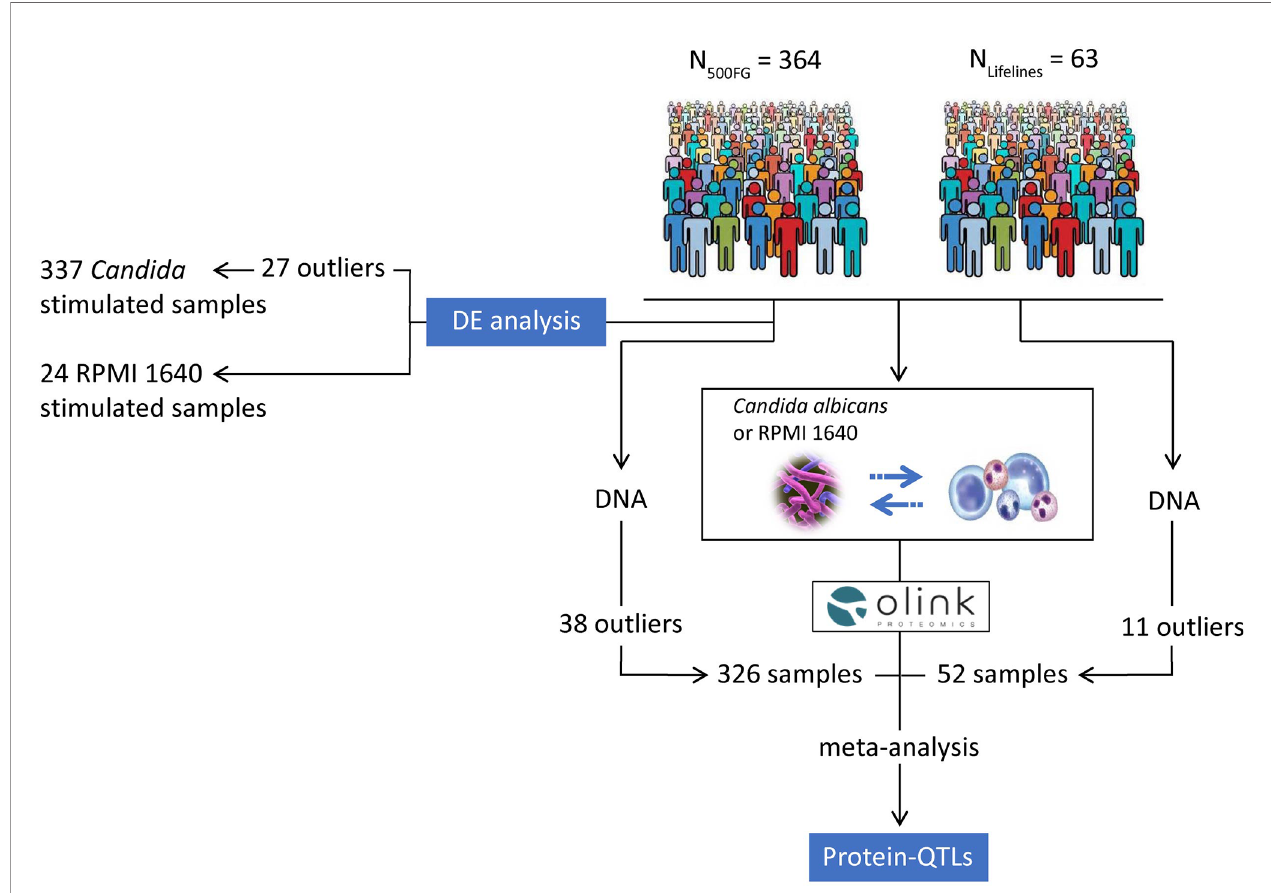
FIGURE 1 | Overview of our study. We pro fi led the proteins released from C. albicans -stimulated PBMCs isolated from healthy individuals belonging to the 500FG (n = 364) and Lifelines Deep cohort (n = 63). We fi rst compared the expression of proteins from Candida -stimulated samples (n = 337) with RPMI 1640-stimulated samples (n = 24) from the 500FG cohort to identify proteins that were signi fi cantly differentially expressed between the two conditions. Before DE protein analysis, we removed outliers that failed QC from OLINK proteomics (n = 26 samples) and one additional sample which had no age and sex information, resulting in 337 samples for DE analysis. In addition, we studied the effect of host genetics on the regulation of in fl ammatory responses by performing a meta-analysis of pQTLs mapped in the 500FG and Lifelines Deep cohorts. For pQTL mapping, we used the proteomic data measured in the 500FG (n = 364) and Lifelines Deep cohort (n = 63). We also obtained the imputed genotypes of the studied individuals. After removing outliers based on the quality control of the genotypes and proteomic data, the total number of samples used for pQTL mapping was 326 and 52 samples in the 500FG and Lifelines Deep cohort respectively. After quality control, we correlated the protein measurements with genome-wide SNP data in each cohort and performed meta-analysis using the summary statistics of pQTLs mapped in the two cohorts to identify genetic variants that in fl uence the levels of in fl ammatory proteins. Stimulations of PBMCs were performed for 24 hours using C. albicans yeast and RPMI 1640 medium as